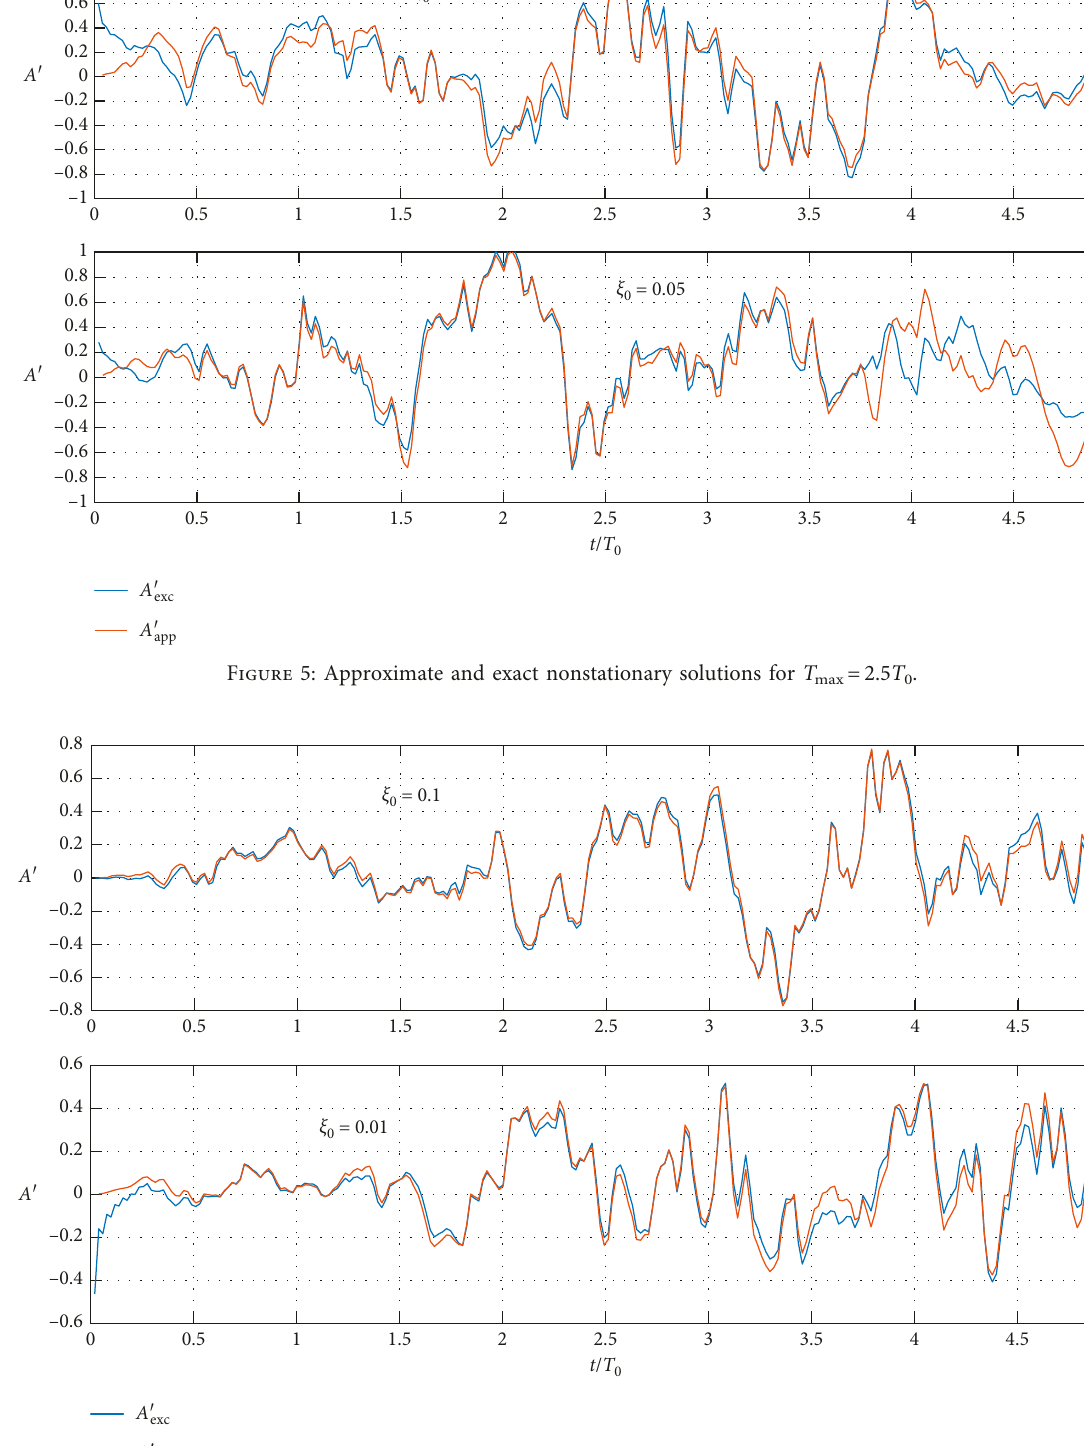
Figure 6: Approximate and exact nonstationary solutions for T